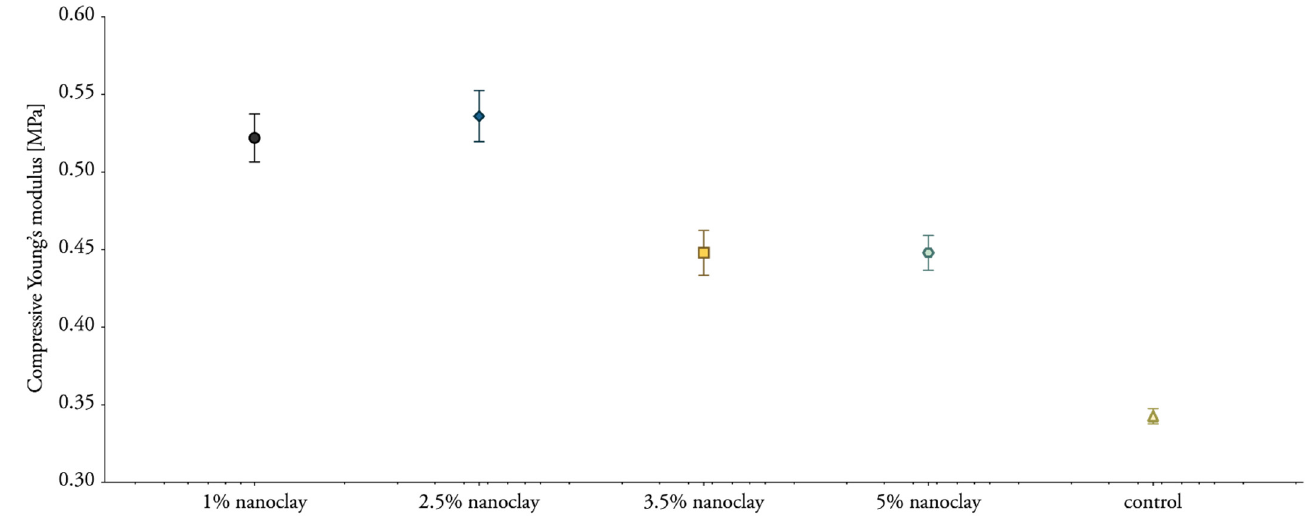
Figure 14. Compressive Young’s modulus of mycelium composites during uniaxial compression with 1 to 5% nanoclay. The standard deviation is performed with 3 specimens (mean ± one standard deviation).